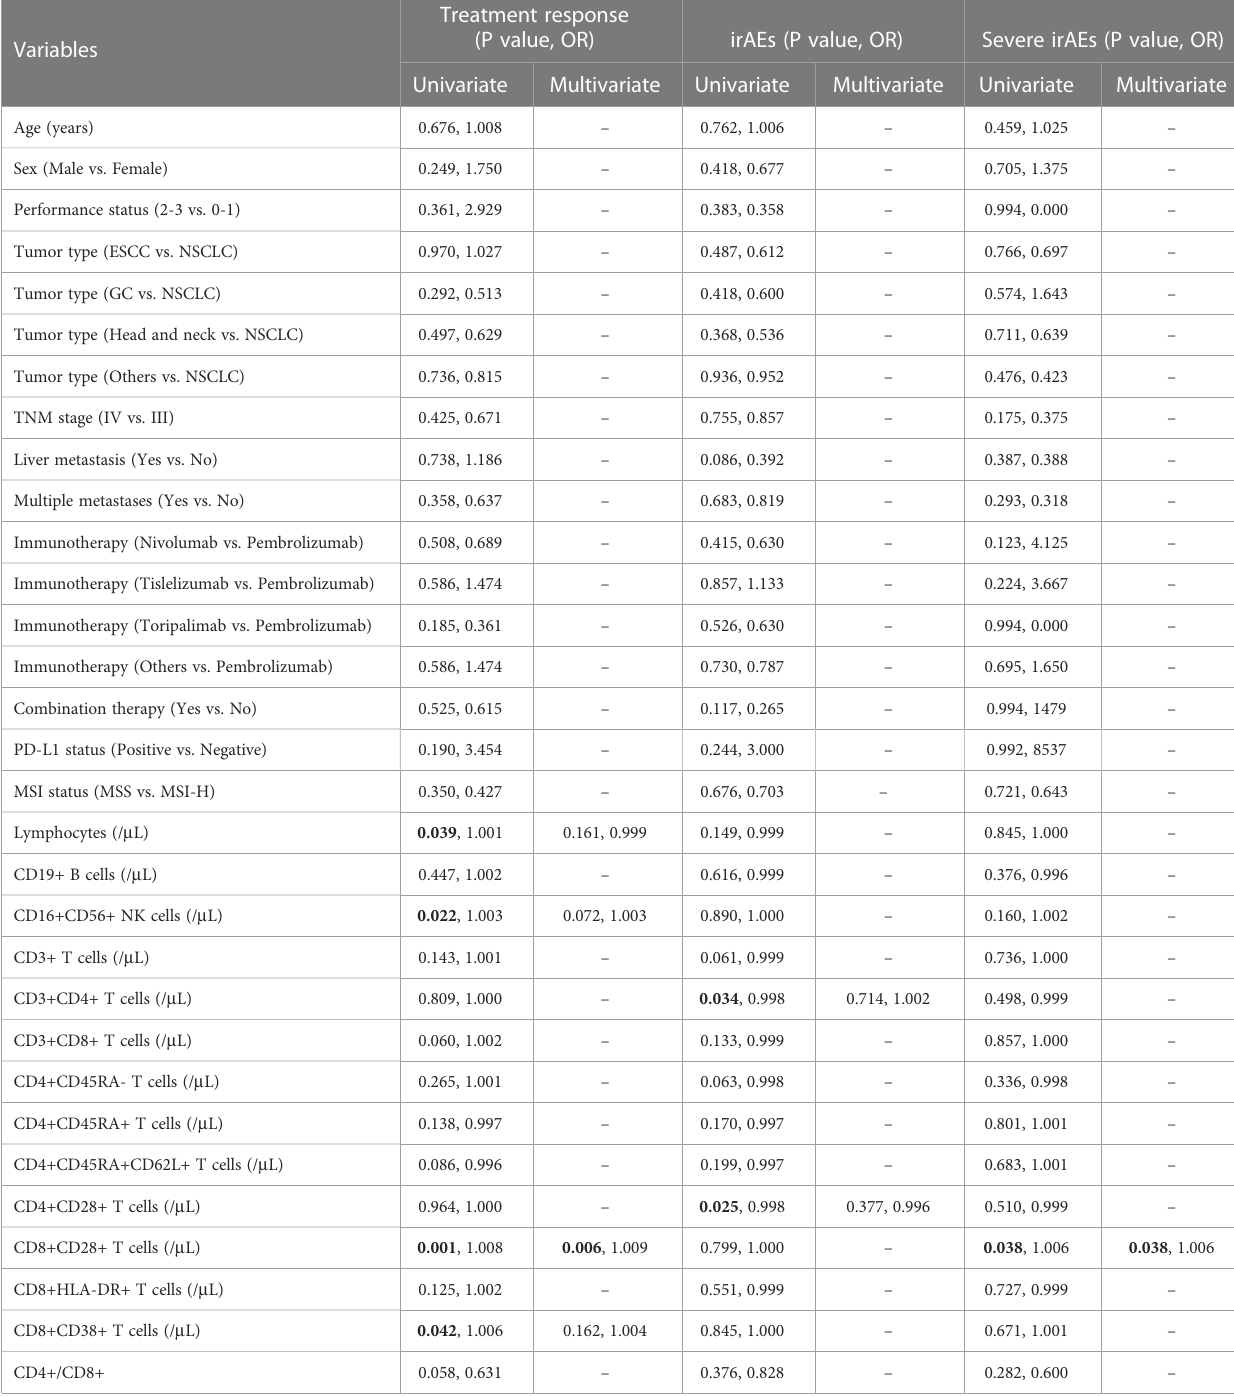
TABLE 2 Univariate and multivariate logistic regression for immunotherapy response, irAEs of any grade, and irAEs of grade